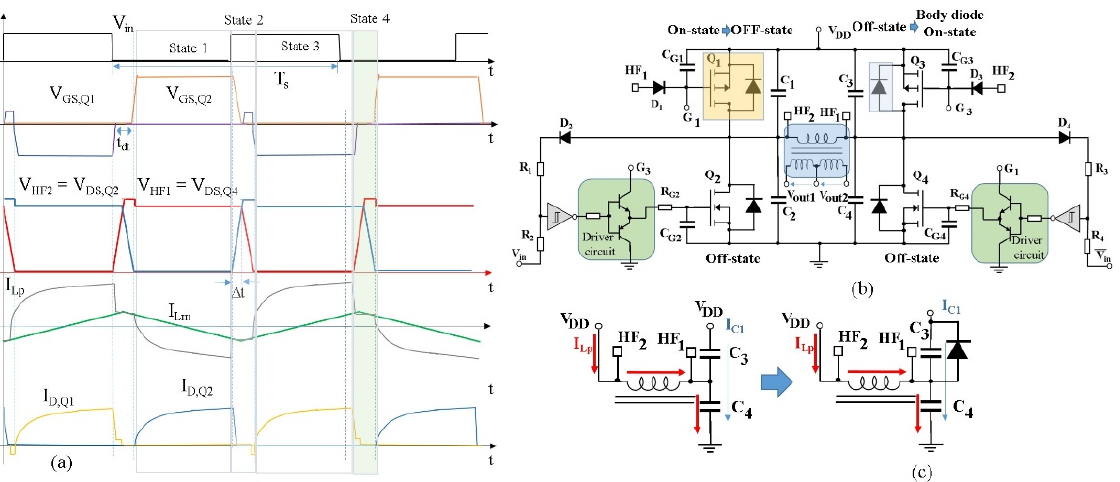
Figure 10. ( a ) Qualitative switching waveforms description at fourth phase of the operative condition (State 4). ( b ) Switching conditions of the MOSFETs and body diodes. ( c ) Primary side of the HF transformer and capacitors’ interactions.